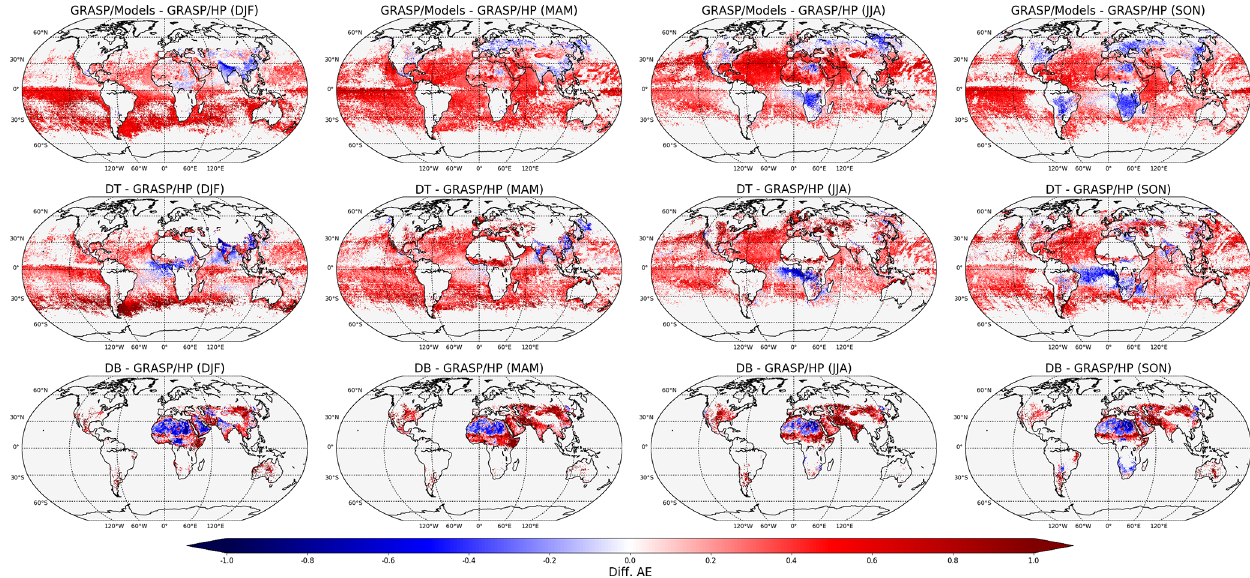
Figure 24. Spatial distribution of seasonal AE differences between PARASOL and MODIS aerosol products, referenced to GRASP/HP.